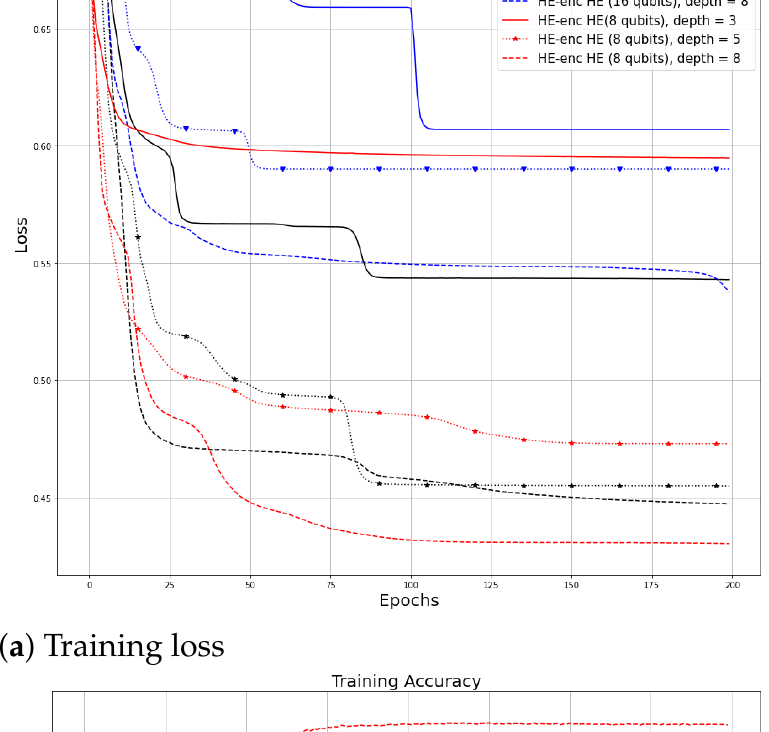
Figure 5. Comparison between qubit-encoding and HE-encoding method at different depth values.